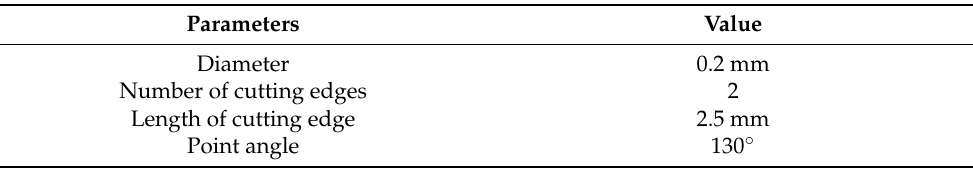
Figure 3. Experimental equipment: ( a ) experimental platform, ( b ) scanning electron microscope, ( c ) micrograph of PCB micro-hole. Table 1. Geometric parameters of micro-bit used in the